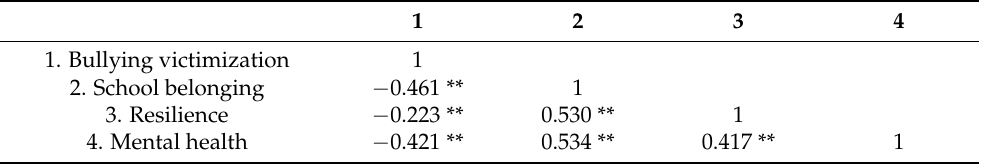
Table 2. Correlation matrix of the study variables.